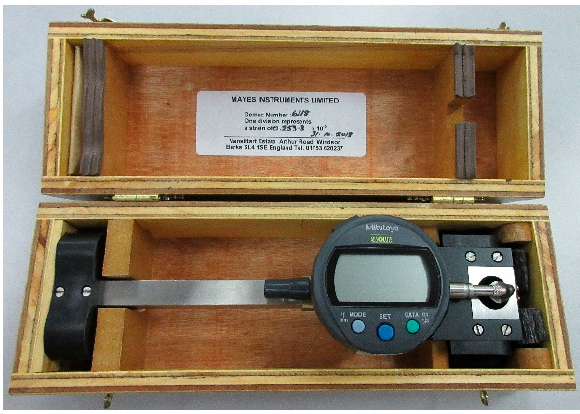
Figure 8. Digital extensometer for measure the sectional strain.